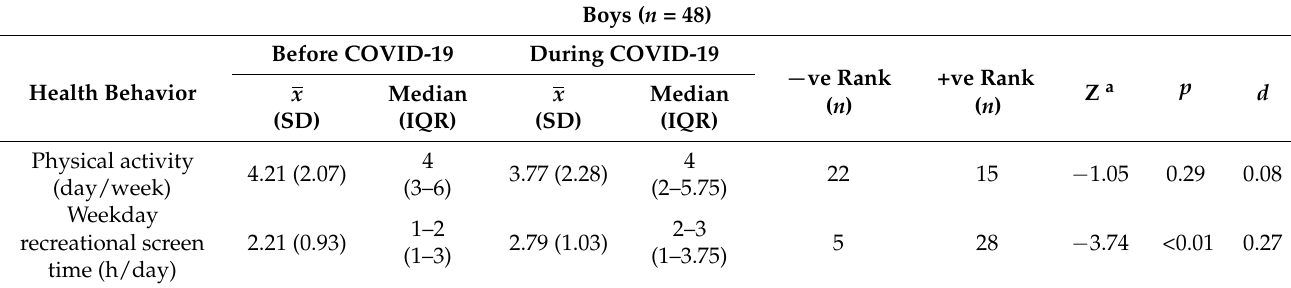
Table 3. Gender differences in children’s physical activity and screen time from before to during